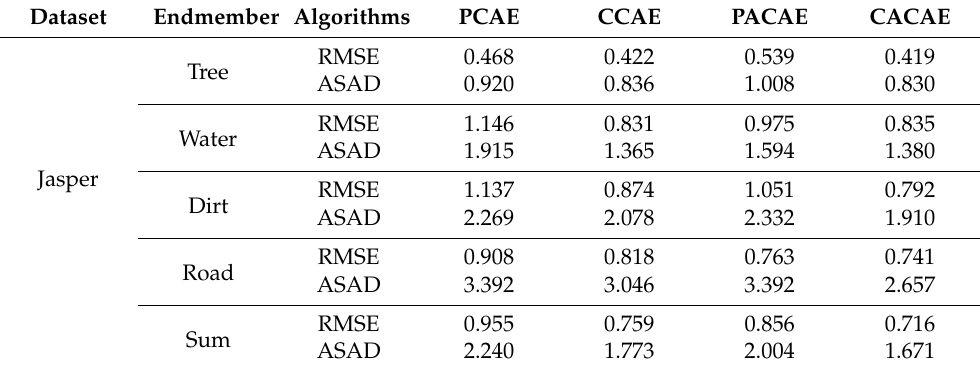
Table 4. RMSE and ASAD results for all endmembers of the Jasper Ridge dataset ( × 10 − 1 ).